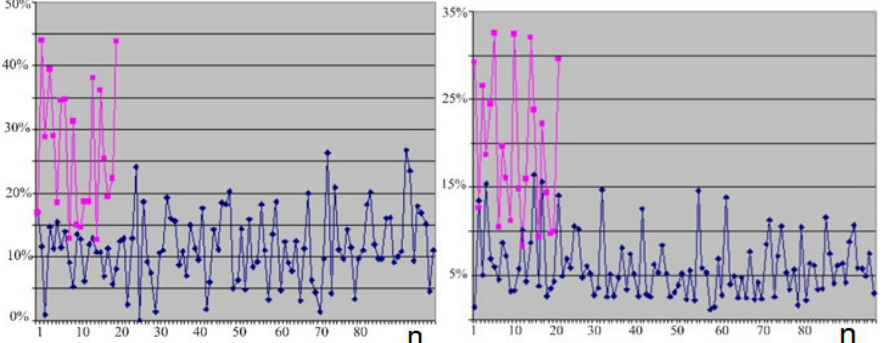
Figure 4. EEG index line diagram (%) in theta band (4–7 Hz) for sites Fp 1 –C 3 ( left ) and EEG power spectrum line diagram (%) in theta range for sites C 3 –O 1 ( right ). Note: n—Number of studies; red line—healthy persons, blue line—outpatients.